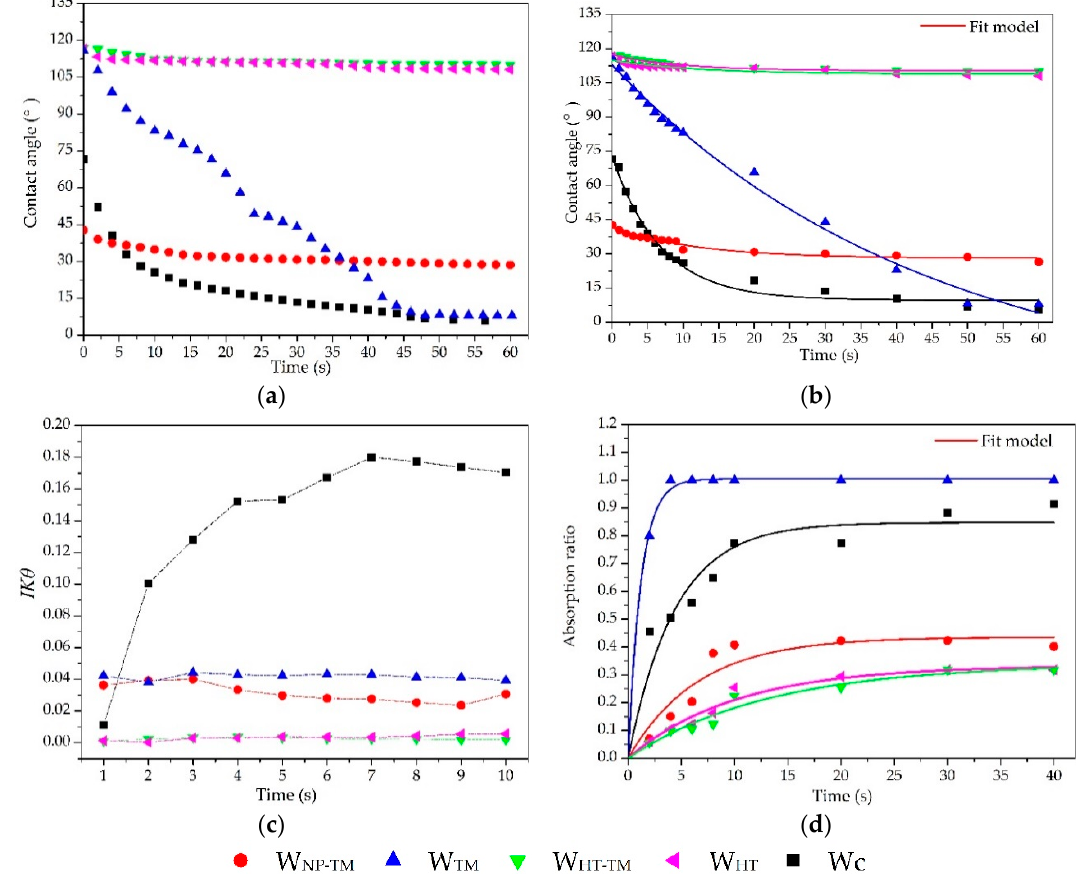
Figure 2. Contact angle curves ( a ), fitting curves of contact angle ( b ), instant decrease rate of contact angle IK θ ( c ), and absorption ratio of the water droplet ( d ) on the surface of untreated and treated poplar.